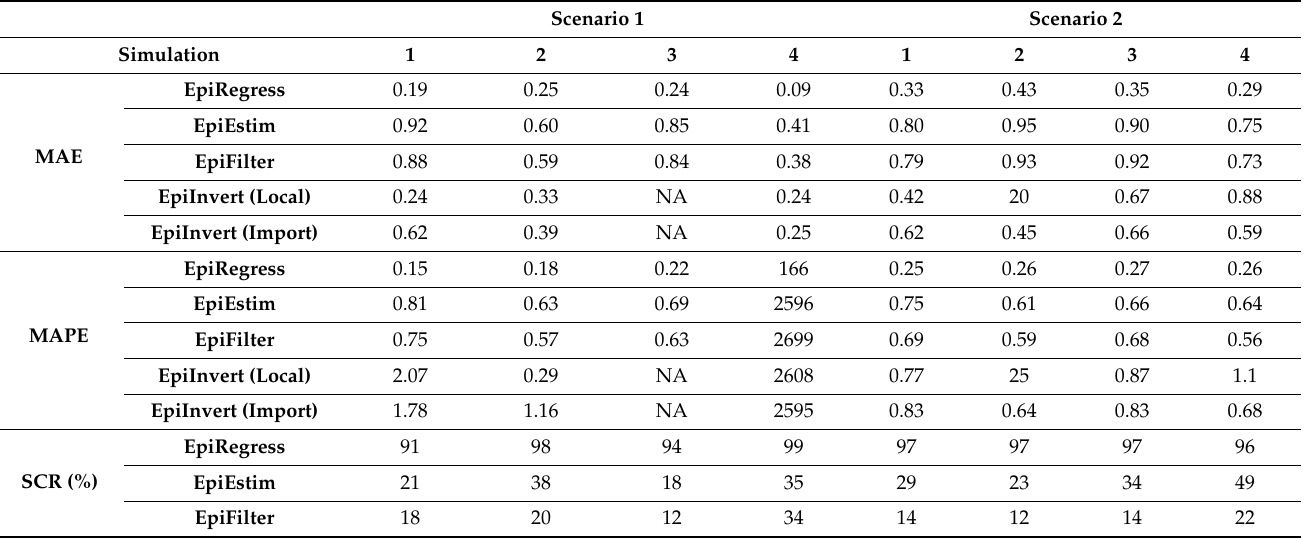
Table 1. Comparison of mean absolute error (MAE) and mean absolute percentage error (MAPE) of R t point estimates by EpiRegress, EpiEstim, EpiFilter, and EpiInvert with imported cases included (‘import’) or excluded (‘local’) in the total case counts, as well as the successful coverage rate (SCR) of the estimated 95% CrIs by